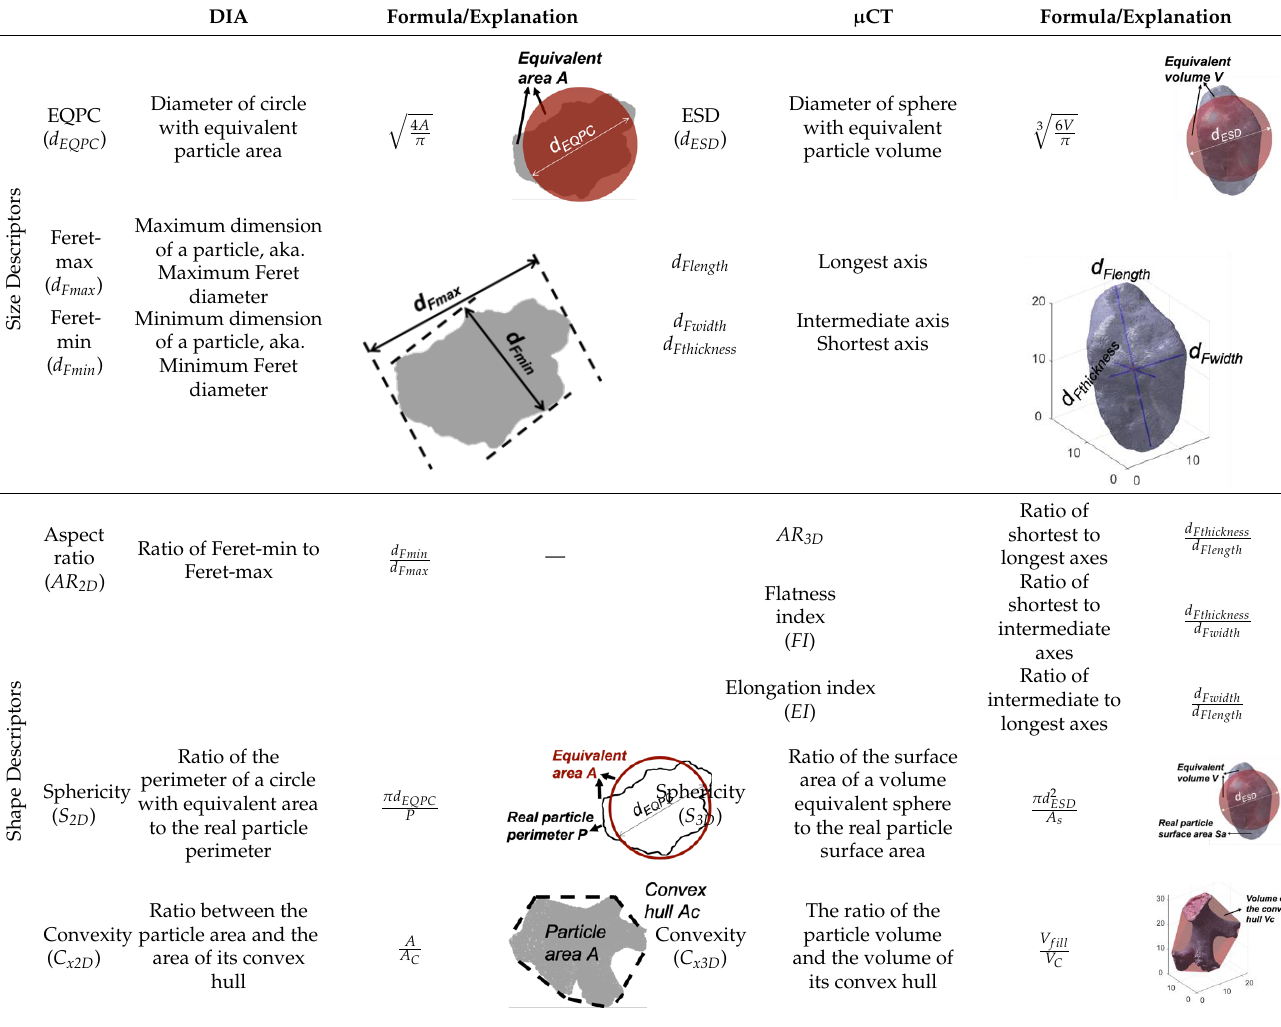
Table 2. Two-dimensional and 3D shape parameter descriptions.